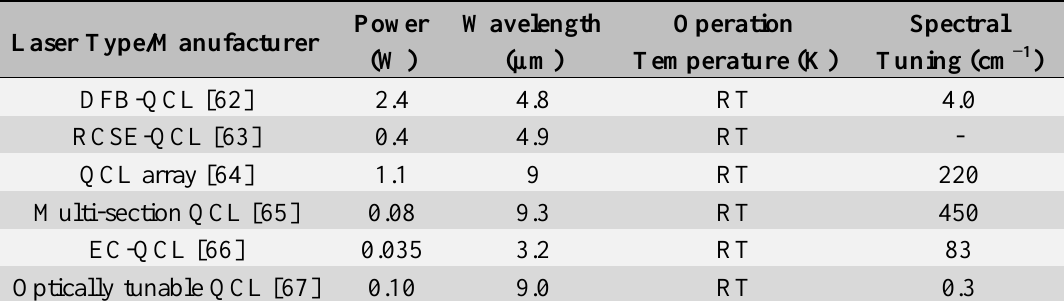
Table 2. Example parameters of selected IR lasers.